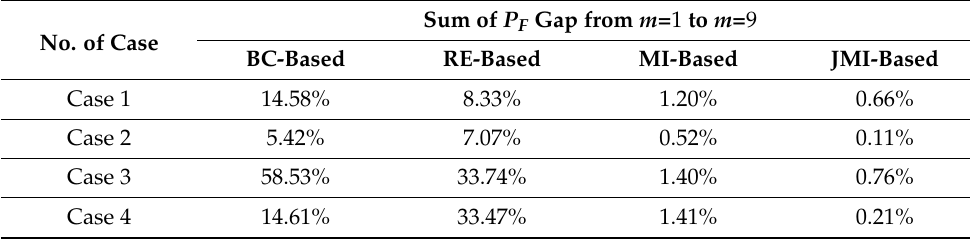
Table 4. Sum of failure probability gaps between each approach and optimal